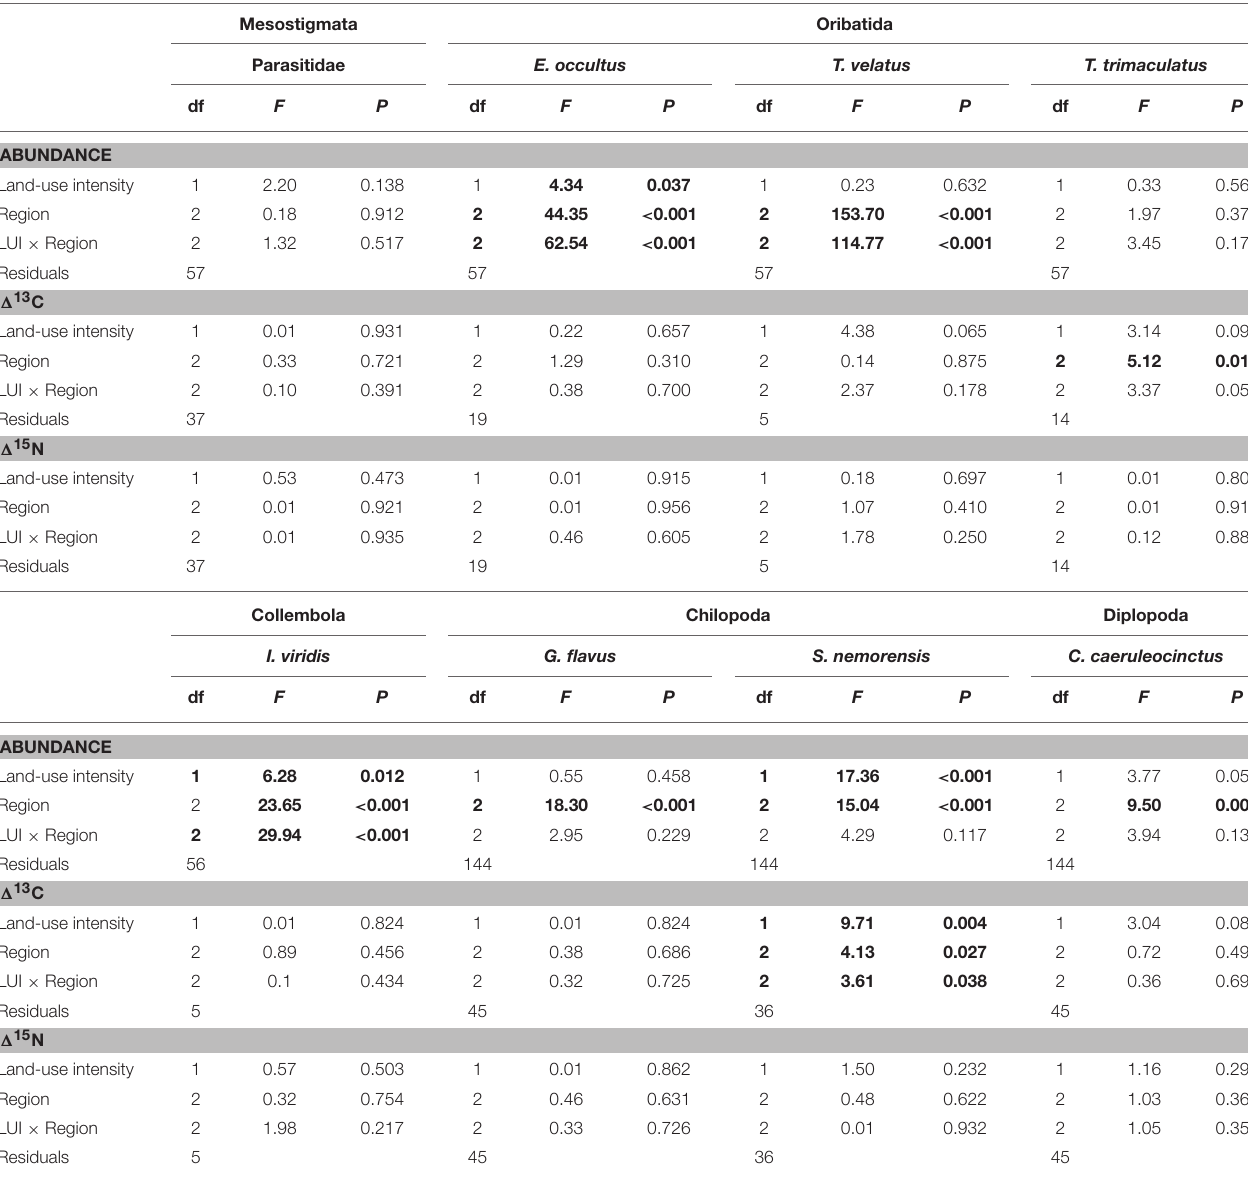
TABLE 2 | Results of permutational analyses of variance with the fixed factor “Region” and the continuous predictor “Land-use intensity” (mean LUI 2008–2010, Blüthgen et al., 2012) for (a) abundance, (b) resource utilization ( 1 13 C), and (c) trophic level ( 1 15 N). Mesostigmata Oribatida Parasitidae E. occultus T.